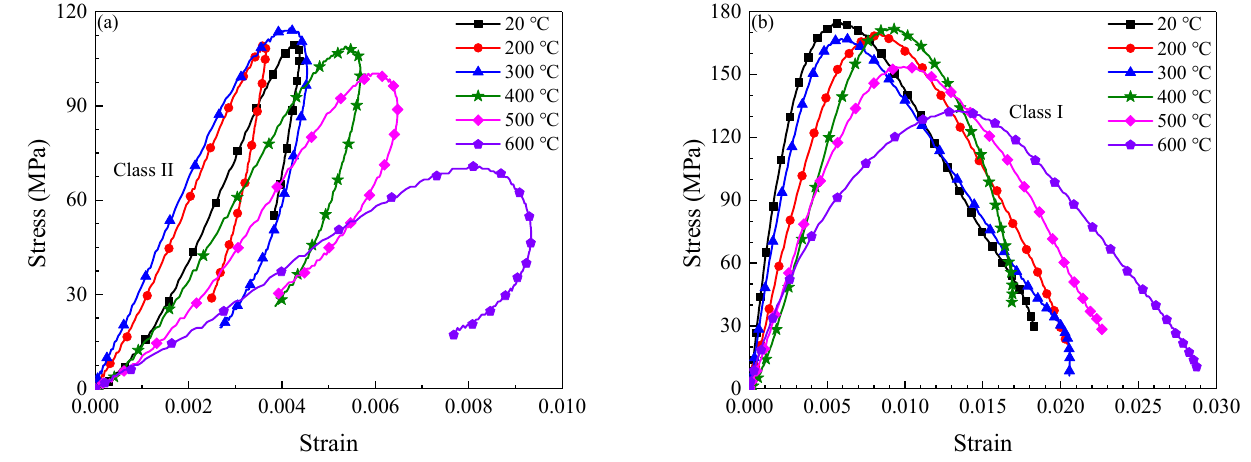
Figure 10. Dynamic stress-strain curves of specimens at different temperature. ( a ) 0.5 MPa, ( b ) 0.9